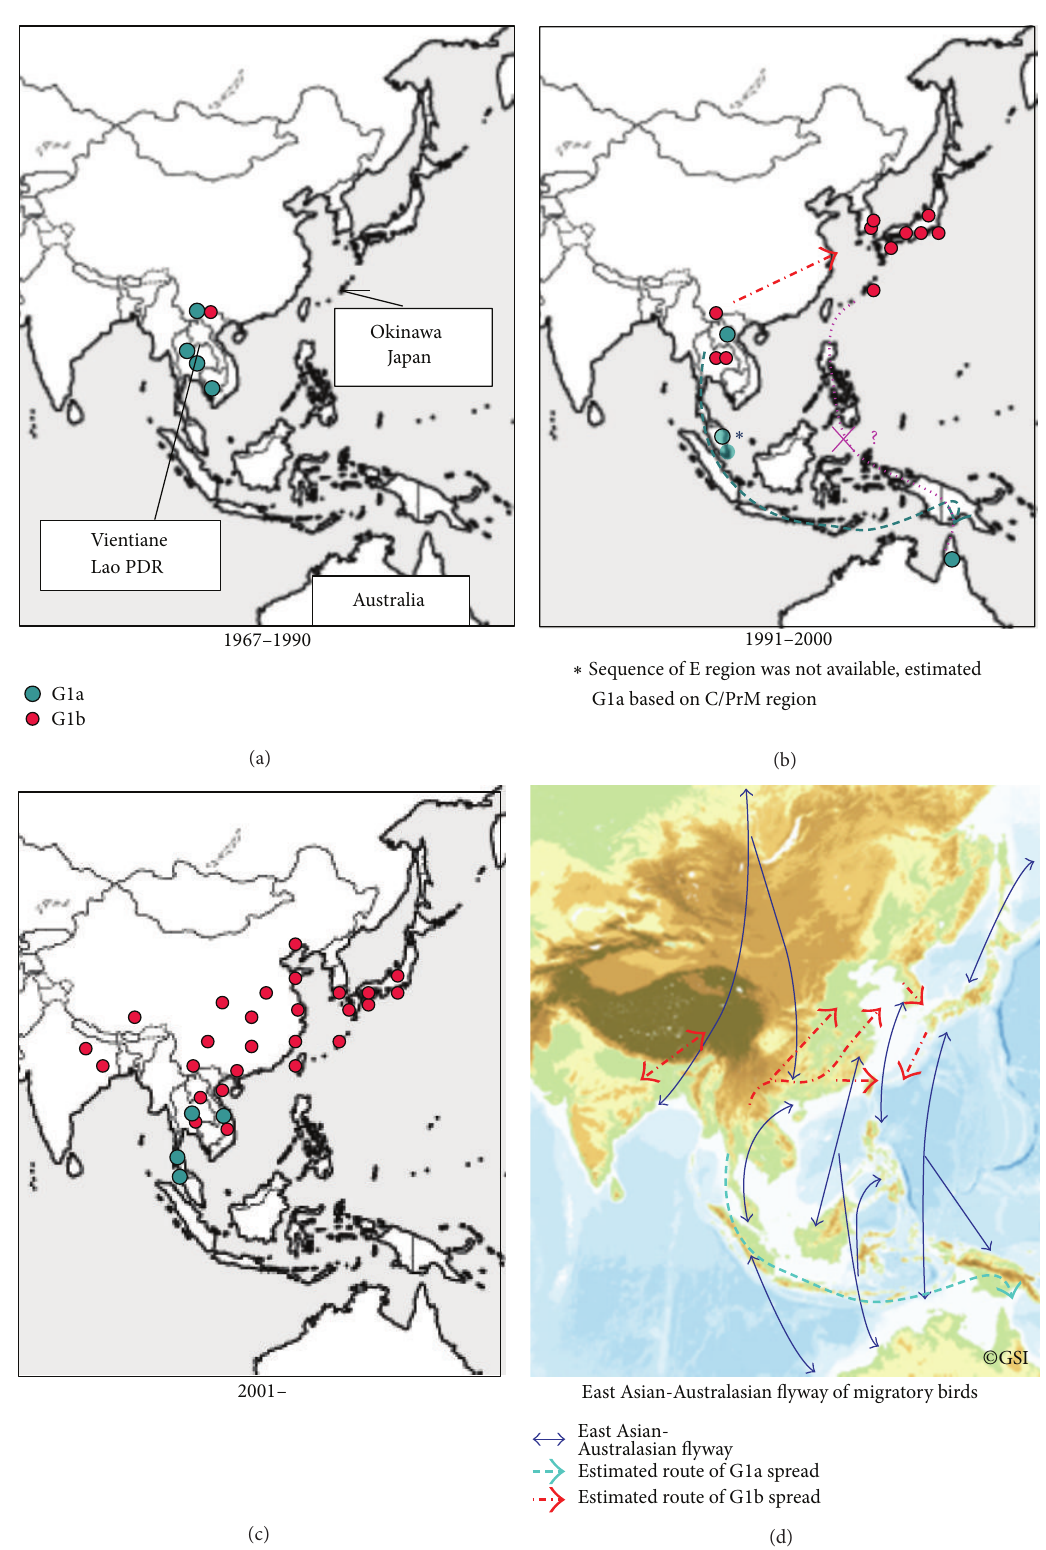
Figure 2: The distribution of subclusters of genotype 1 JEV in each time period, 1967–1990, 1991–2000, and 2001–. The blue dots represent G1a and red dots G1b represent isolates analyzed in this study and published strains. The lower right panel shows an altitude map with the EastAsian-Australasianflywaysofmigrationcitedfromhttp://www.ozcoasts.gov.au/indicators/shorebird counts.jspandestimatedmigration routes of G1a and